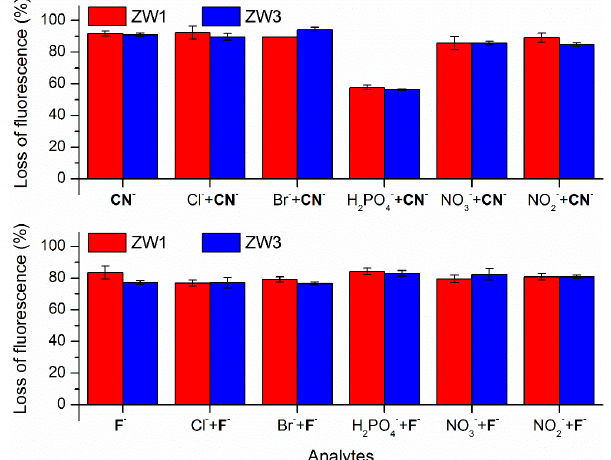
Figure 6. Histograms of the loss of fluorescence intensity registered for acetonitrile solutions of ZW1 and ZW3 ([ ZW ] = 6 × 10 − 6 M, λ exc = 406 nm) upon the addition of 1 equivalent of F − or CN − ([F − ] or [CN − ] = 6 × 10 − 6 M ) and 1 equivalent of another anion ([ anion ] = 6 × 10 − 6 M). The average of three independent experiments is plotted in each case.